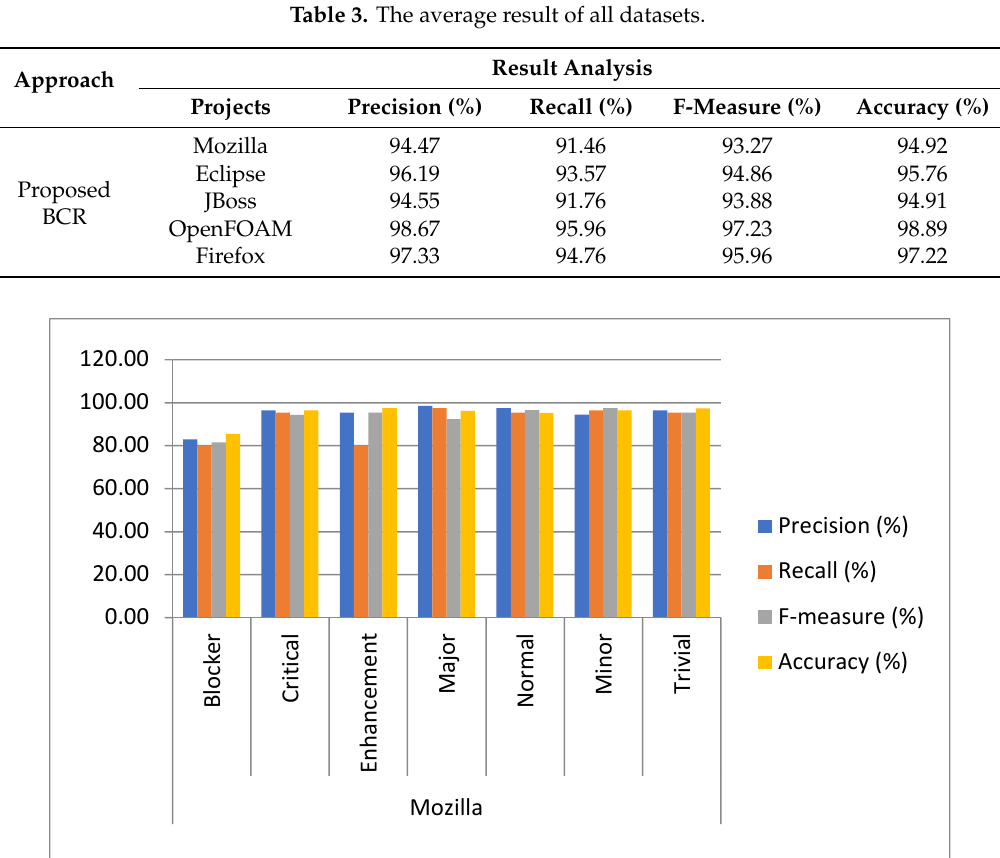
Figure 6. Results analysis of the proposed BCR on seven classes of the Firefox Project.